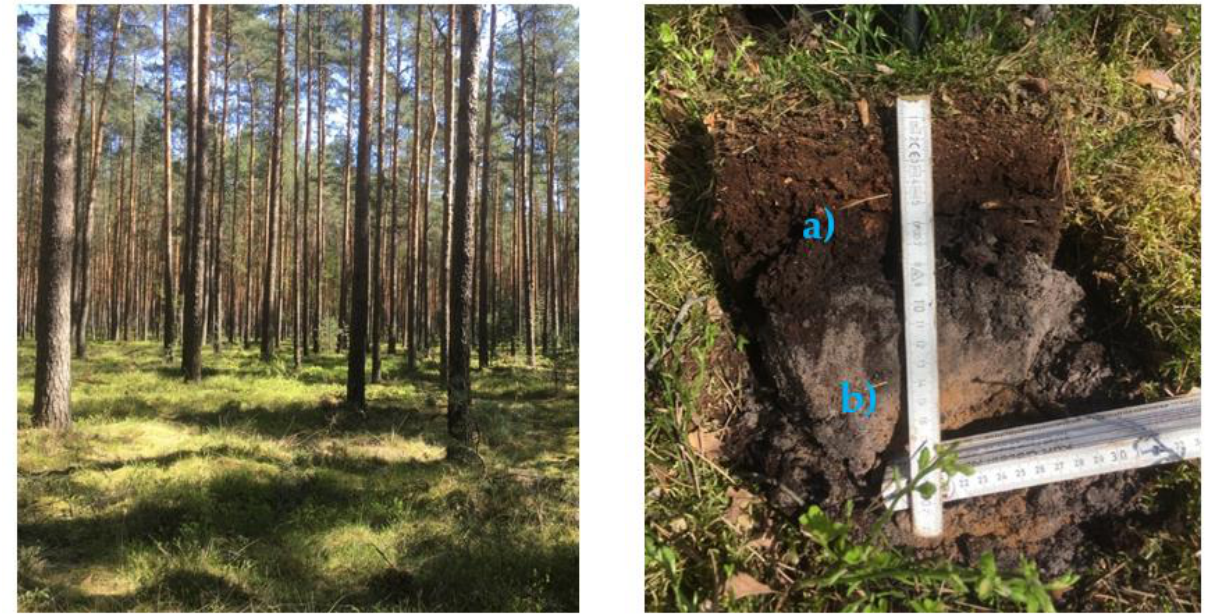
Figure 1. Collection spots of the soil samples. Official names by the authority of Sachsenforst, Pirna, Germany (arrows, red), the numbers in brackets describe the pH of top soil (first number) and min- eral soil (second number). Forest stand of soil 277 and 89 is deciduous forest, of 171 and 141 spruce forest and of 295 and 30 pine forest. Map credit [18] (Original Author: TUBS; license link: https://commons.wikimedia.org/wiki/Commons:GNU_Free_Documentation_License,_ver- sion_1.2).